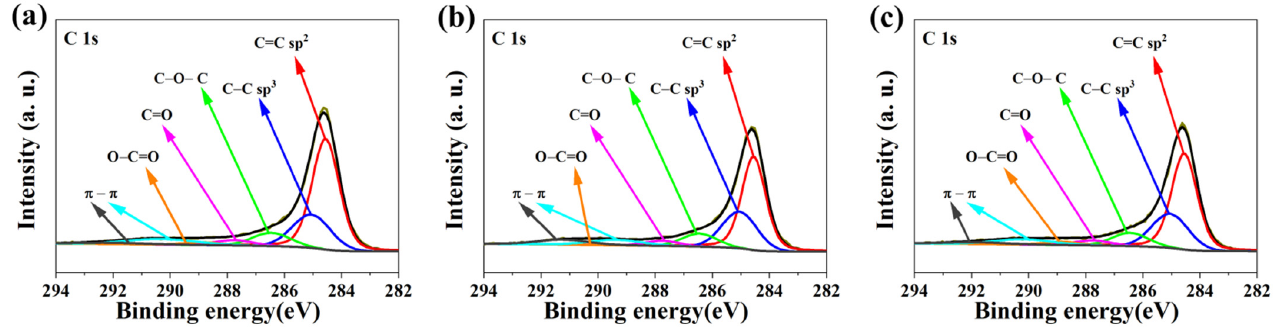
Figure 6. XPS spectra for C1s of representative samples of the obtained N-rich activated carbons: ( a )